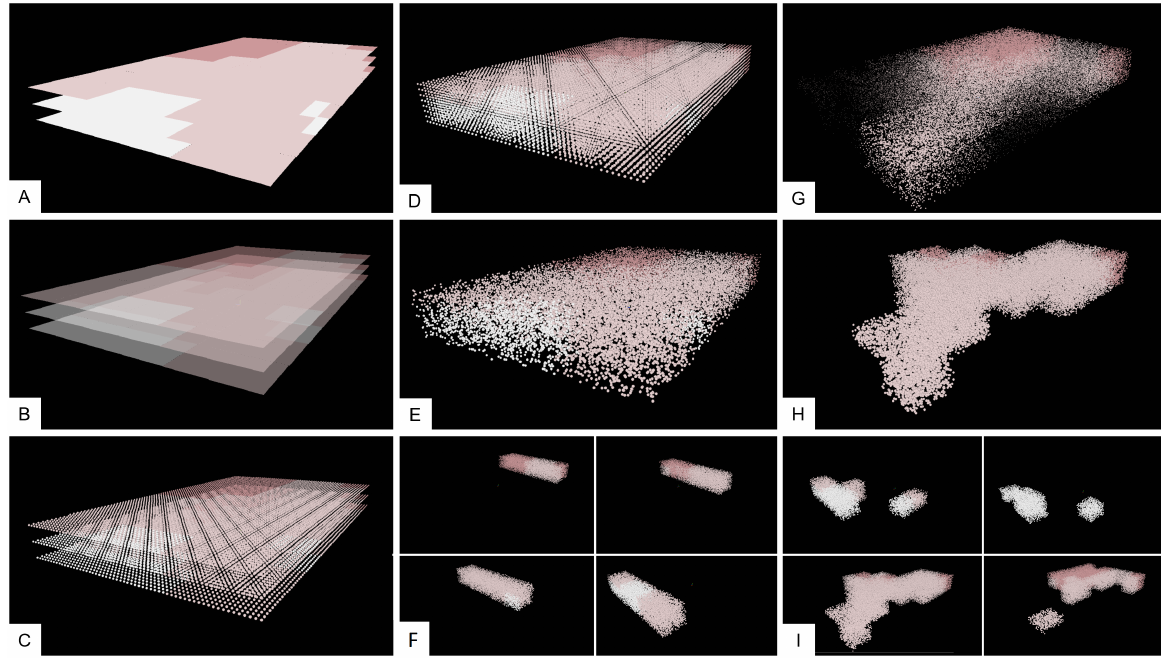
Figure 4. Representing 3D climate data by series of horizontal 2D planes or by a 3D point cloud; (A) representing 3D data by series of 2D planes; (B) exploring the use of transparency when visualizing data through series of 2D planes; (C) representing 3D data by series of 2D point clouds; (D) representing 3D data by a 3D cloud of regularly spaced points; (E) representing 3D data by a 3D cloud of randomly spaced points; (F) animation of a moving slice of a 3D point cloud along a horizontal axis; (G) varying points size and density in the 3D cloud according to climate data value; (H) filtering points of the 3D cloud according to climate data value; (I) using animation to display data value intervals one after the